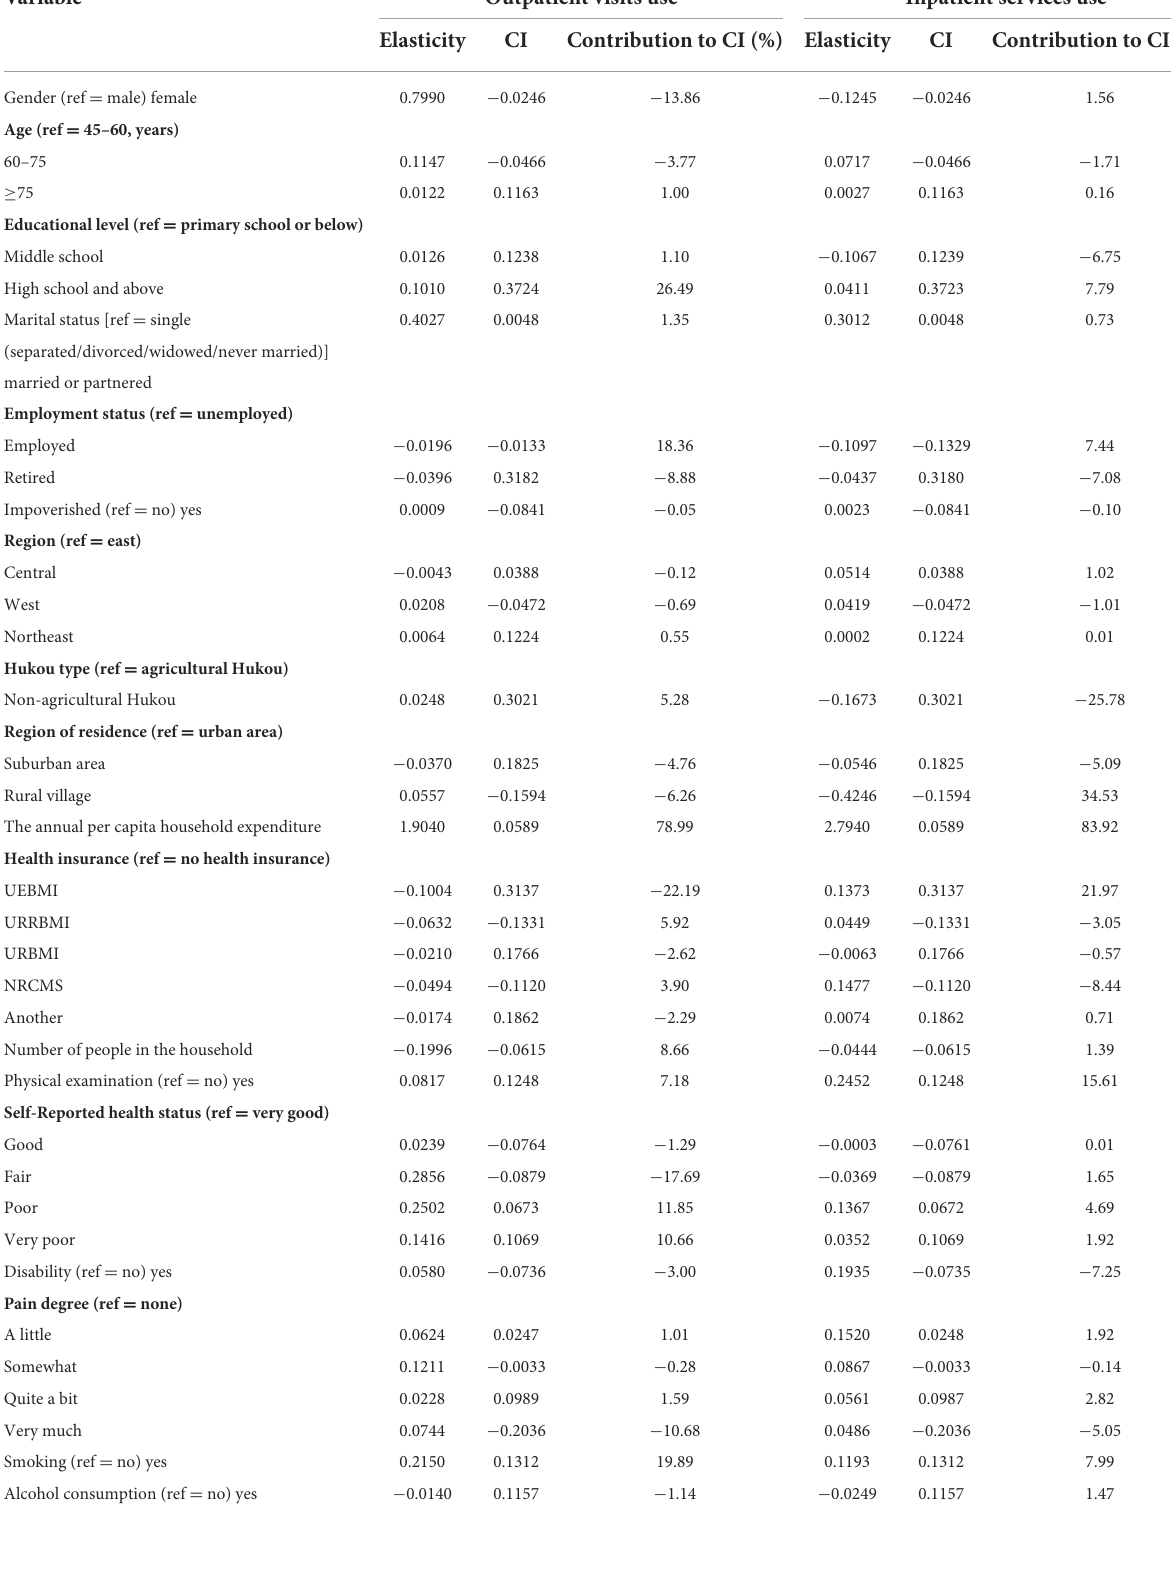
TABLE 3 Decomposition of socioeconomic-related inequalities in the use of outpatient and inpatient services among cancer patients. Variable Outpatient visits